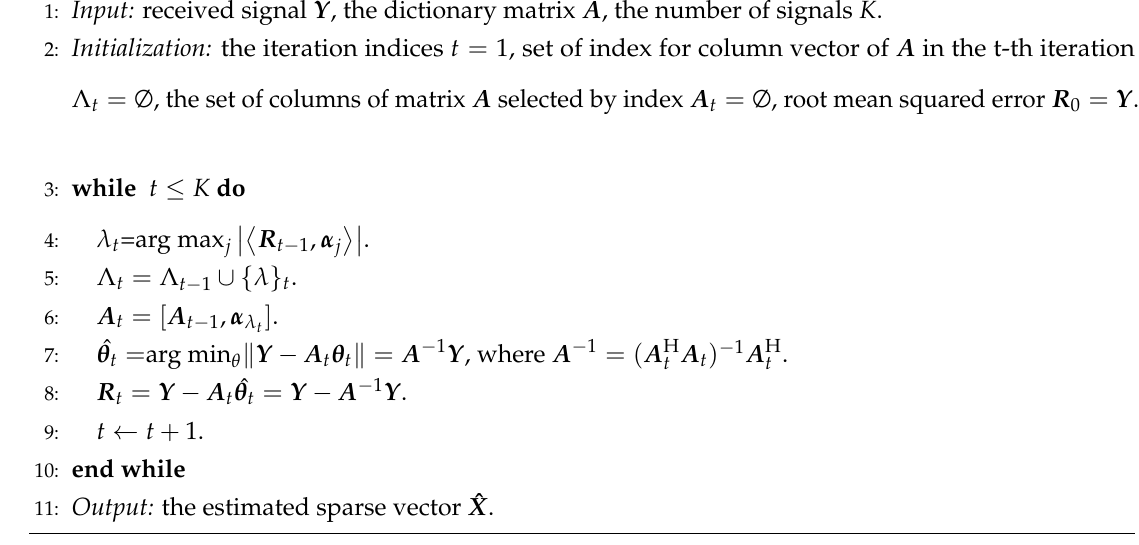
Algorithm 2 SOMP algorithm to estimate the